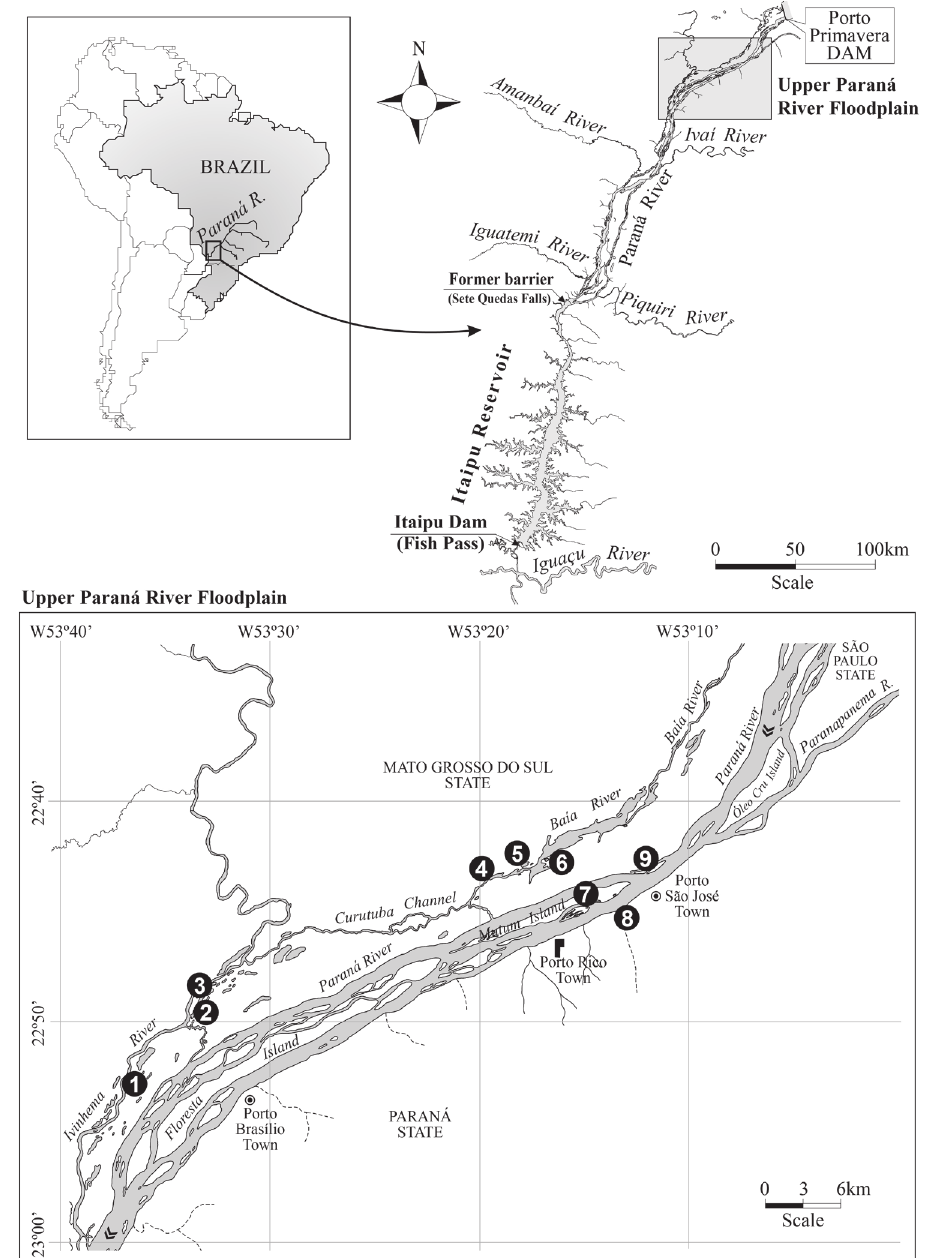
FIGURE 1 | Location of the Upper Paraná River floodplain (downstream of the Porto Primavera dam and upstream of the Itaipu reservoir) and the nine sampling stations on the Paraná, Baía, and Ivinhema